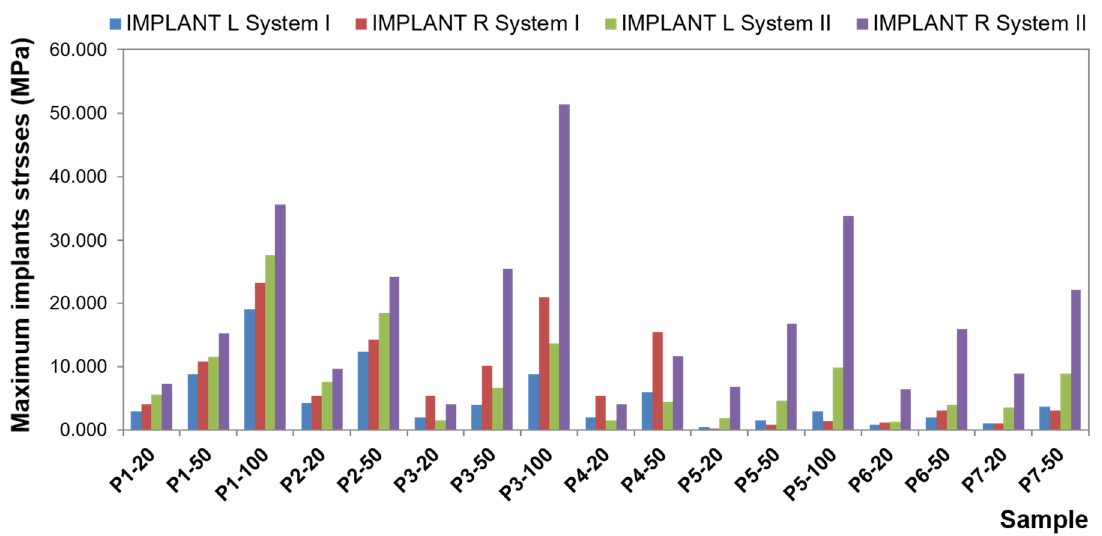
Figure 12. Maximum implant stresses in the first and second system (explanation: L—left; R—right).